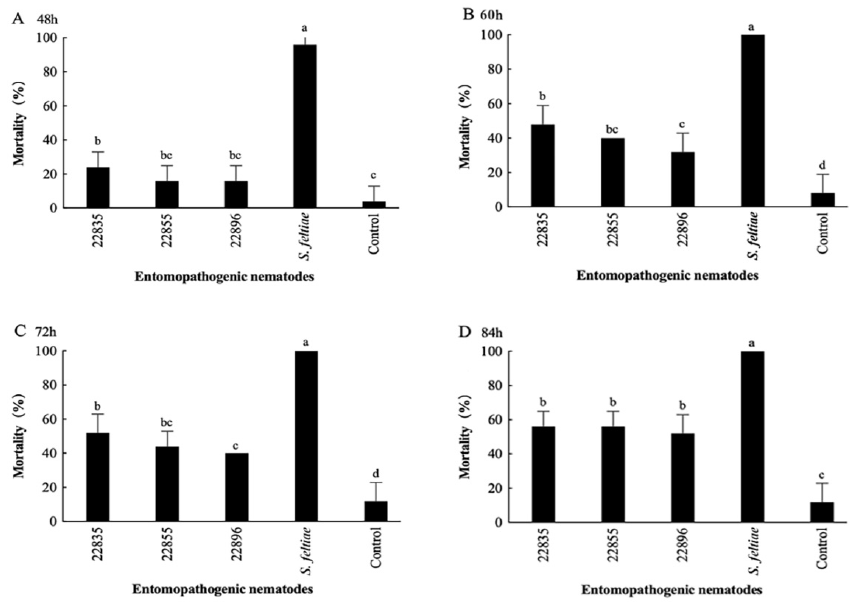
Figure 5. Mortality (mean ± SE) of the sixth-instar larvae of Spodoptera frugiperda treated with different entomopathogenic nematodes for 48, 60, 72, and 84 h (( A – D ) 100 IJs larva − 1 ). Bars with different letters represent significant differences between treatments by Tukey’s test ( p < 0.05). S. feltiae : Stei- nernema feltiae ; 22835: Oscheius myriophilus ; 22855: Heterorhabditis spp.; 22896: Oscheius spp.